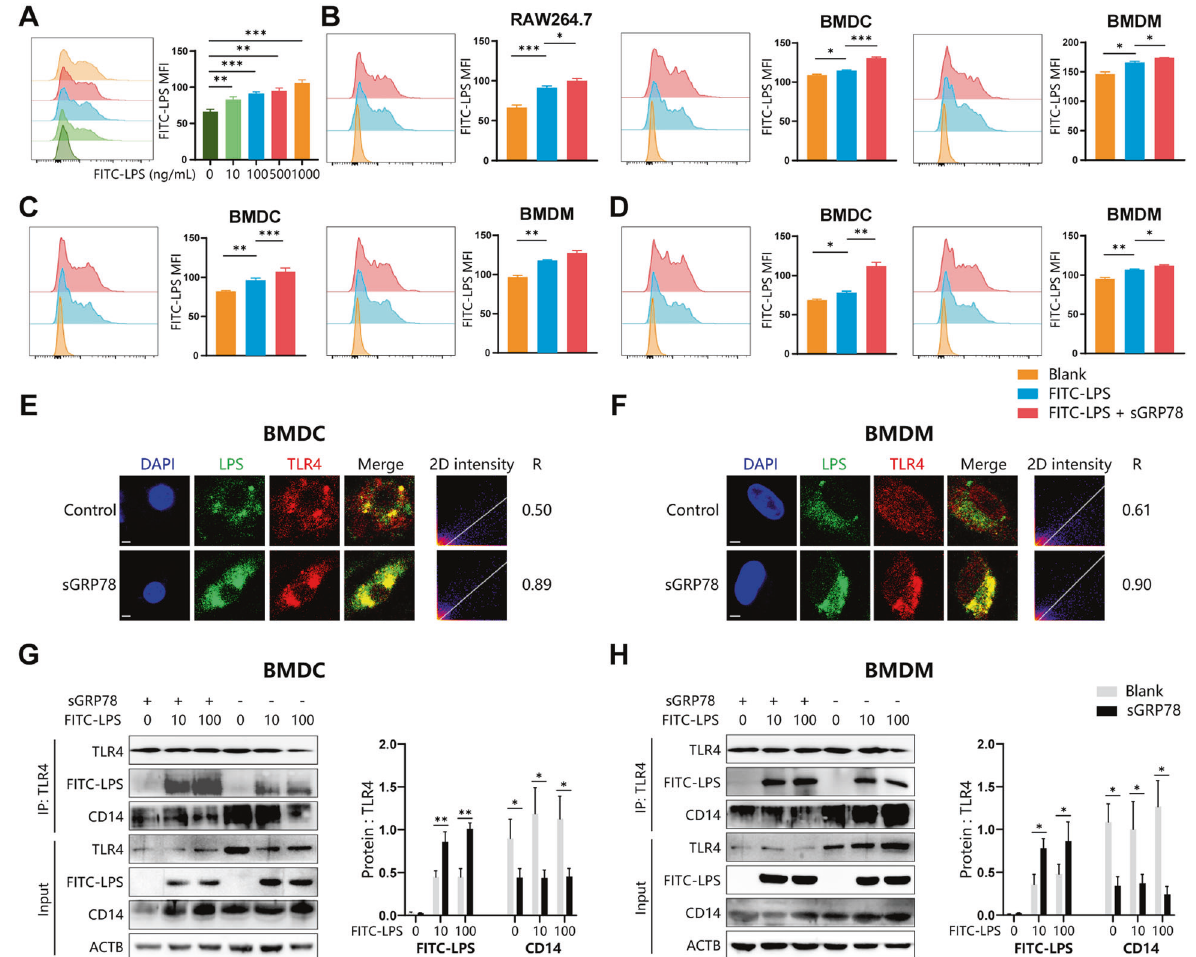
Fig. 1 sGRP78 promotes endocytosis of LPS – TLR4 complex. A RAW264.7 was treated with FITC-LPS at indicated concentrations for 1 h. B Cells were treated with GRP78 (20 μ g/mL) and/or FITC-LPS (100 ng/mL) for 1 h. C , D To remove FITC-LPS fl uorescence on the plasma membranes, cells in ( B ) were treated with acid-washing ( C ) or anti-FITC antibodies for fl uorescence quenching ( D ). LPS binding was assessed by FCM. Representative histograms (left), and the MFI of FITC-LPS were quanti fi ed (right). E BMDCs and BMDMs F were treated with FITC-LPS for 0.5 h. FITC-LPS and stained TLR4 were detected by confocal microscopy (CLSM). Scale bar = 2 μ m. The colocalization between FITC-LPS and TLR4 was described by 2D intensity histogram and Pearson's R value. G , H Immunoprecipitation assay for endogenous TLR4 with FITC-LPS or CD14. Data are representative of three independent experiments with similar results or mean ± SEM from three independent experiments. * P < 0.05, ** P < 0.01, and *** P <